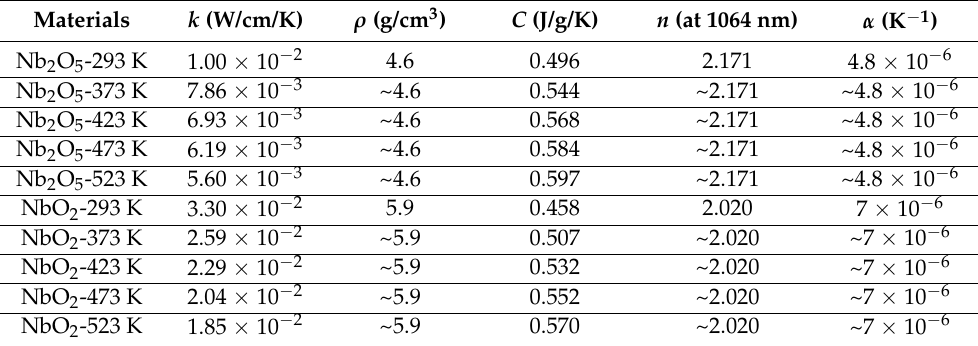
Table 2. Parameters of materials under different